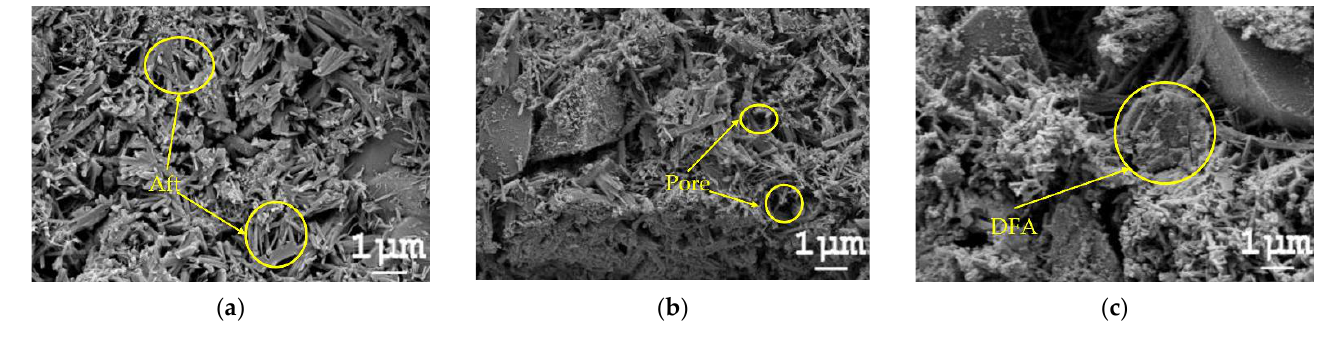
Figure 10. SEM analysis of H2 ( a ) H2-1 ( b ) H2-3 ( c ) H2-6.